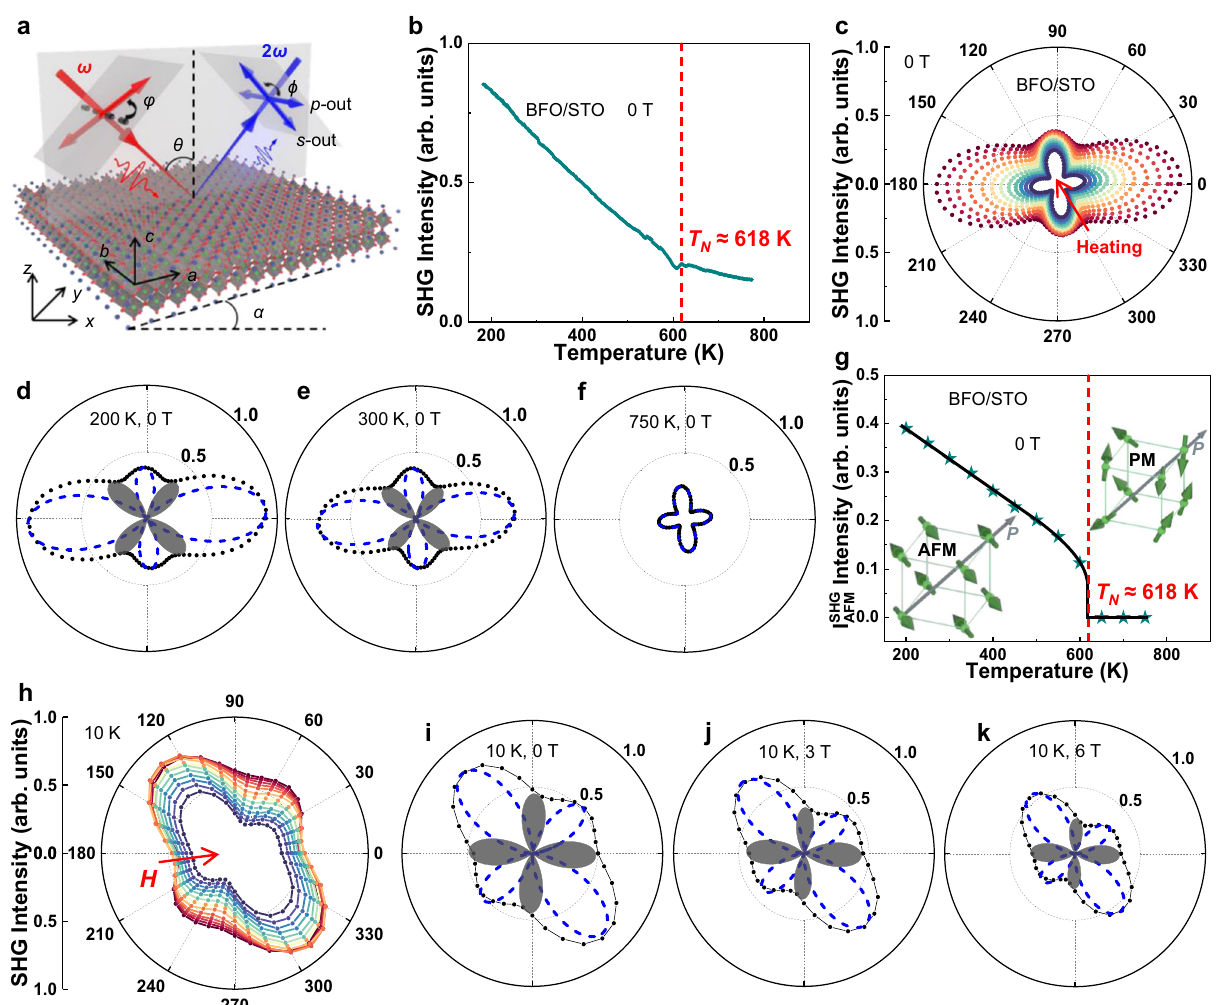
Fig.2|Widetemperature-range(RA-)SHGandthatwithappliedmagnetic fi eld ( H ) measurements. a Schematic diagram of the polarization con fi guration in the re fl ective geometric light path. b The SHG intensity of BFO fi lms as a function of temperatureinthe p - p polarizationcon fi guration. c RA-SHGmeasurementsofBFO/ STO fi lmsatdifferenttemperatures,thescatteredpointsaretheexperimentaldata at different temperatures. d – f Theoretical fi tting results of RA-SHG measurements of BFO/STO fi lms at 200, 300, and 750K, respectively. The scattered points are experimental data, the blue dashes represent the contribution of the ferroelectric ordertotheSHGsignal,andthegrayshadedareasrepresentthecontributionofthe